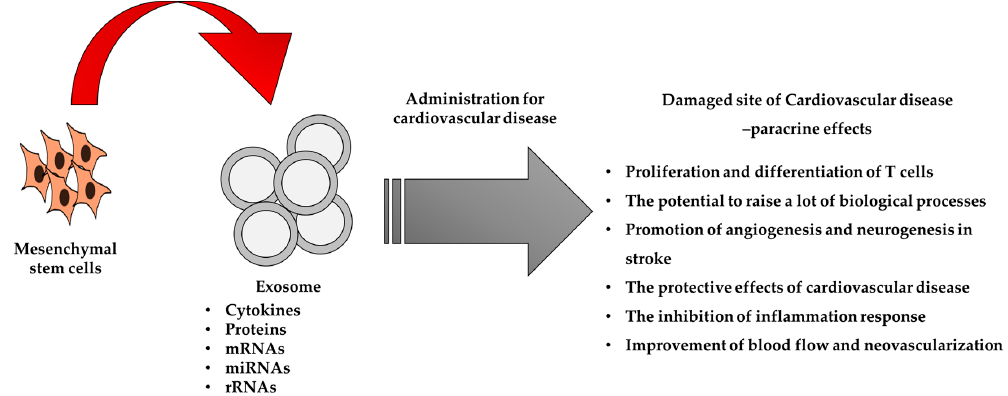
Figure 3. A schematic illustration of the roles of MSC-derived exosomes in the treatment of CVD via paracrine paracrine effects.